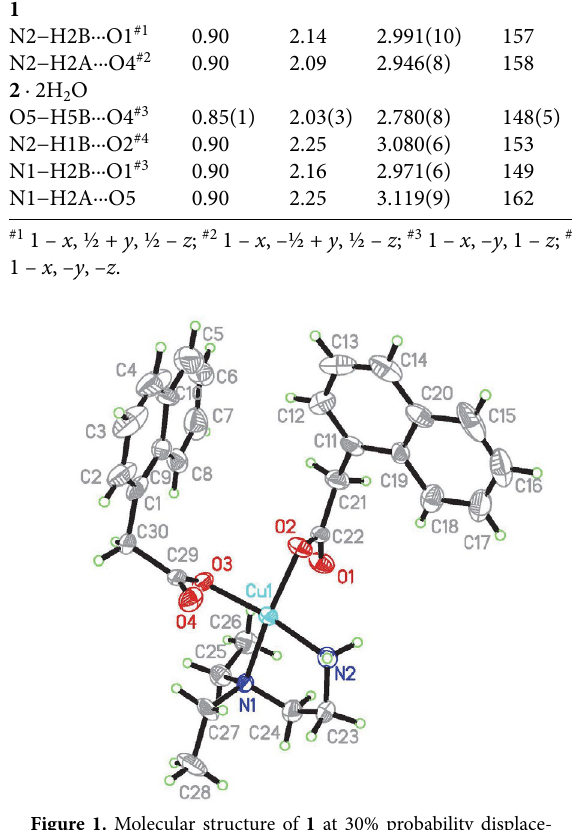
Figure 1. Molecular structure of 1 at 30% probability displace-